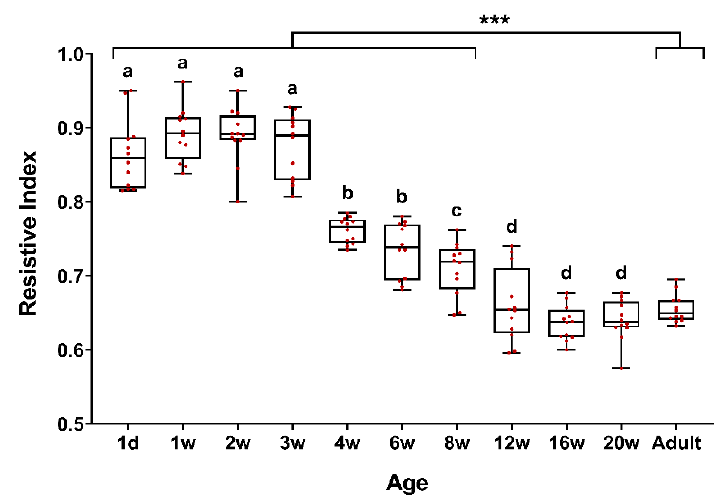
Figure 1. Box-whisker plot showing the renal resistive index (RRI) over the age of the puppies and the adult dogs. Horizontal lines in the boxes represent the median, the bottom, and top of the boxes, the 25th and 75th percentiles; and the whiskers indicate the minimum and maximum values. The red points indicate the RRI value of each dog for each kidney. *** Indicates differences ( p ≤ 0.05) between the ages of puppies and adult dogs. a–d: Indicates differences ( p ≤ 0.05) between the puppies’ ages.